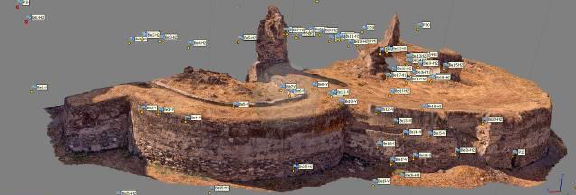
Figure 4. Partial model externally oriented with TLS control points.